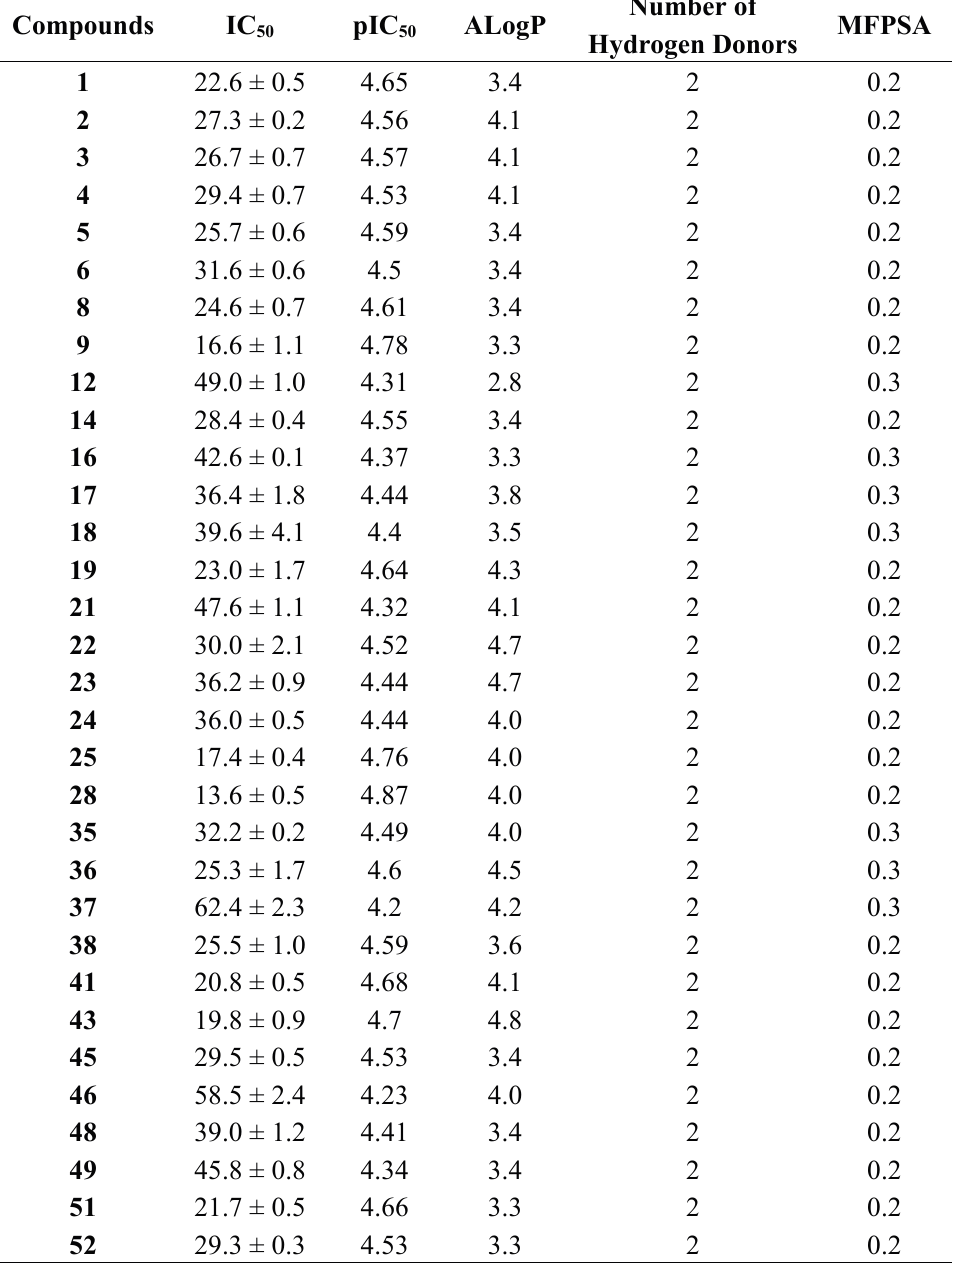
Table 6. IC 50 , pIC 50 , ALogP, number of hydrogen donors and molecular fractional polar surface area (MFPSA) values of selected active